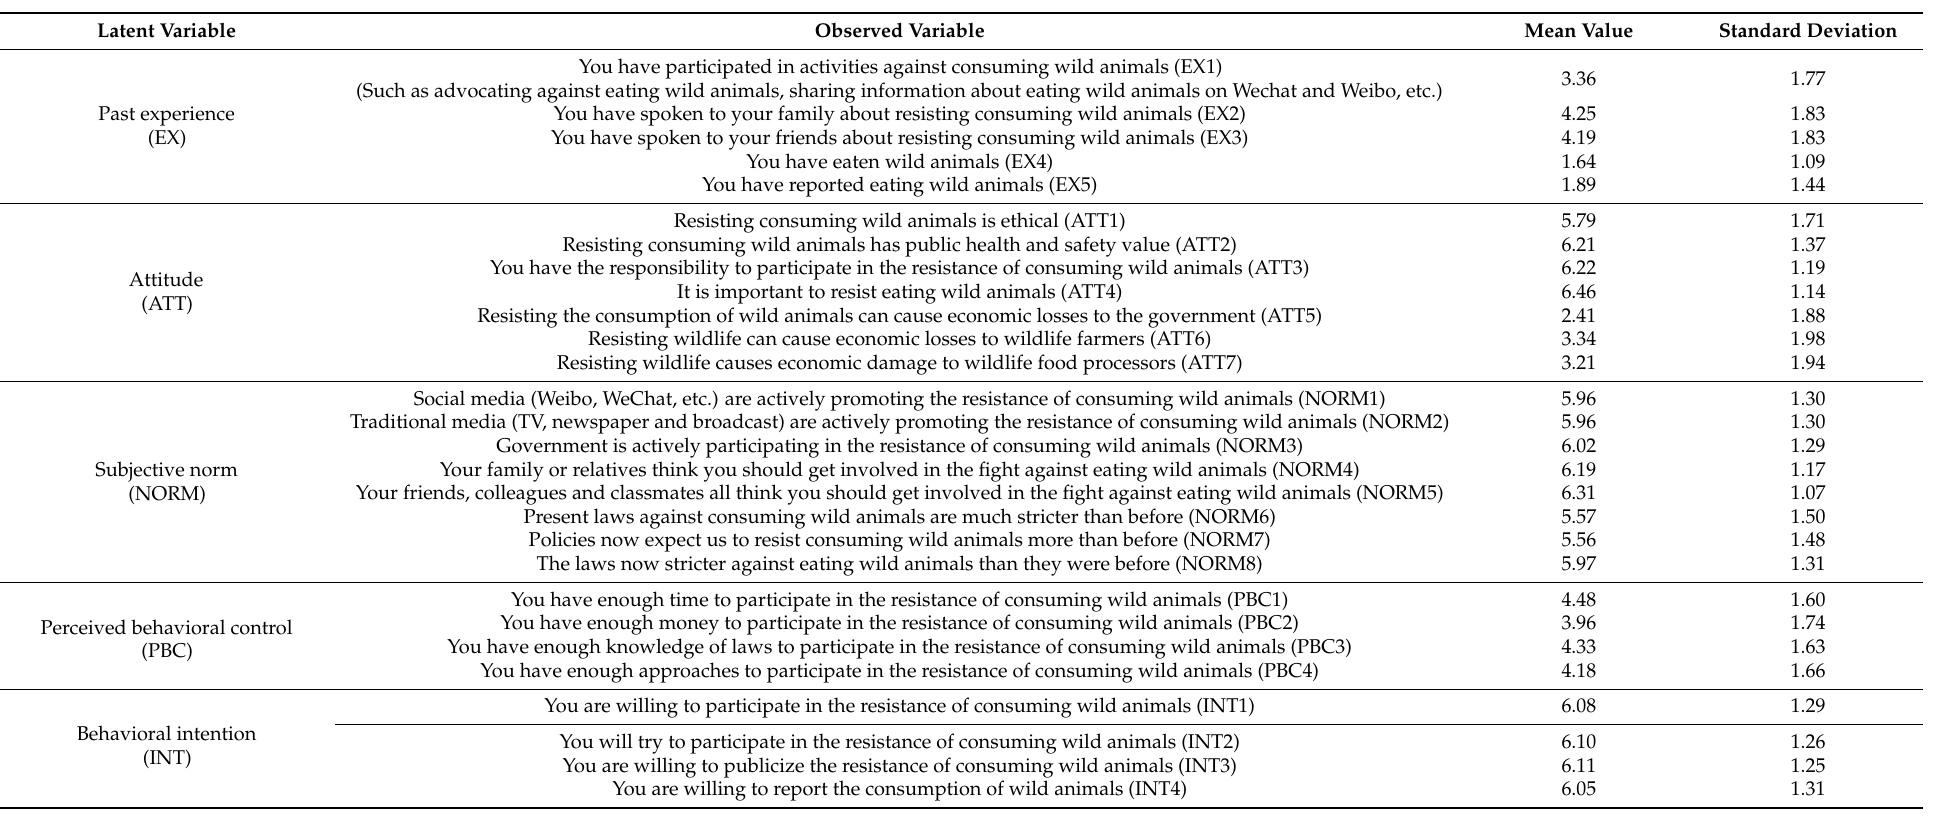
Table 2. Descriptive statistics of the observed